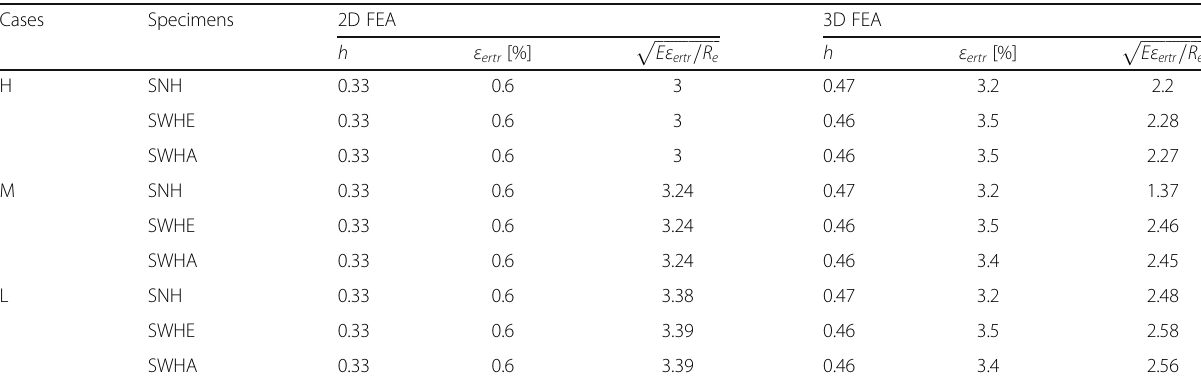
Table 10 Degree of multiaxiality h , critical value of total strain ε ertr and factor